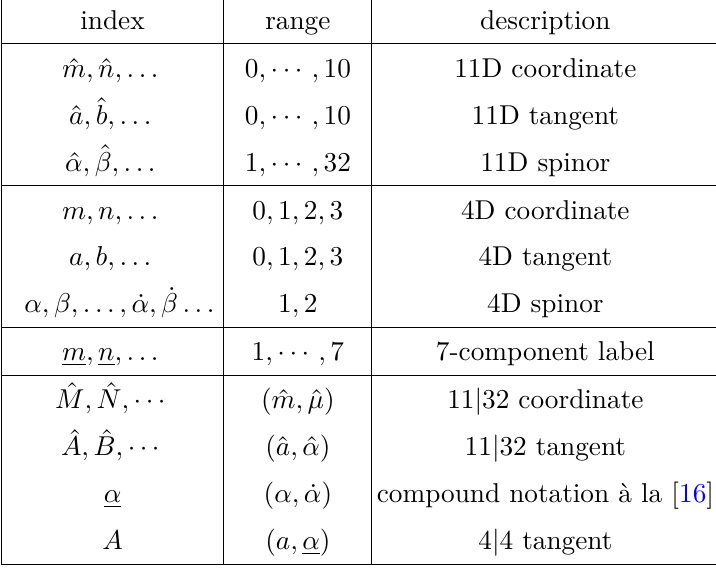
Table 1 . Legend of indices. Indices of various 7 -dimensional representations ( GL(7) coordinate, SO(7) tangent, G representation, and label for seven extra gravitini) have all been identified to 2 avoid proliferation of